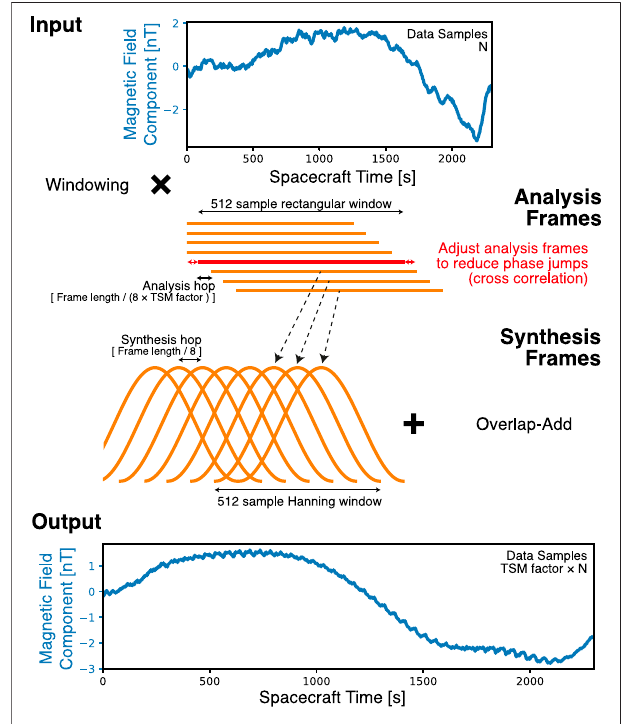
FIGURE 3 | Illustration of the Waveform Similarity and Overlap Add (WSOLA)